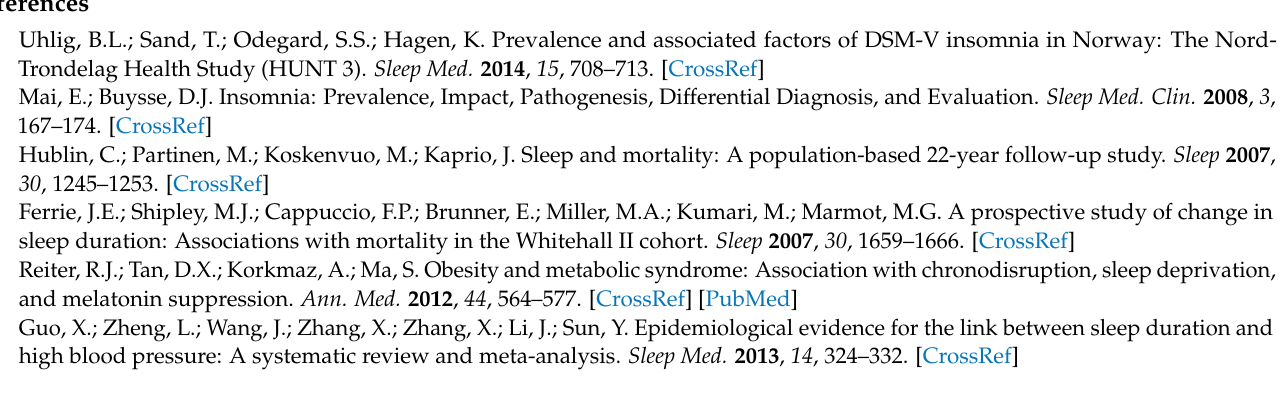
Figure S3: (A) changing both wake and sleep onset times (a) (B) changing only onset sleep time (b1) (C) changing only wake onset time t. (b2) Left panels: Simulated CSR schedules used. Middlepanels: Cortisol circadian rhythms with increasing levels of CSR. Color of line reflects schedule in left panels. (C) Phase of the cortisol rhythm with different levels of CSR. Color of line reflects schedule in left panels, Figure S3: (A) Simulated 48 hours of CRH (blue) and ACTH (red) profiles under the nominal light schedule [maximal light intensity of 1000 lux after simulated sunrise (6AM) and a minimal light intensity of 0 lux after simulated sunset (6PM)] and habitual sleep schedule. Timing of sleep (black shaded bars at top of panels) and light-dark (white and grey shaded regions respectively) are indicated as in Figure 2. (B) Nominal cortisol rhythms qualitatively matched to mean normalized experimental cortisol observations from [1], Figure S4: ACTH circadian rhythms in response to varying durations of chronic sleep restriction as a result of (A) changing both wake and sleep onset times (condition a) (B) changing only sleep onset time (condition b1) (C) changing only wake onset time (condition b2), Table S1: List of parameters in the